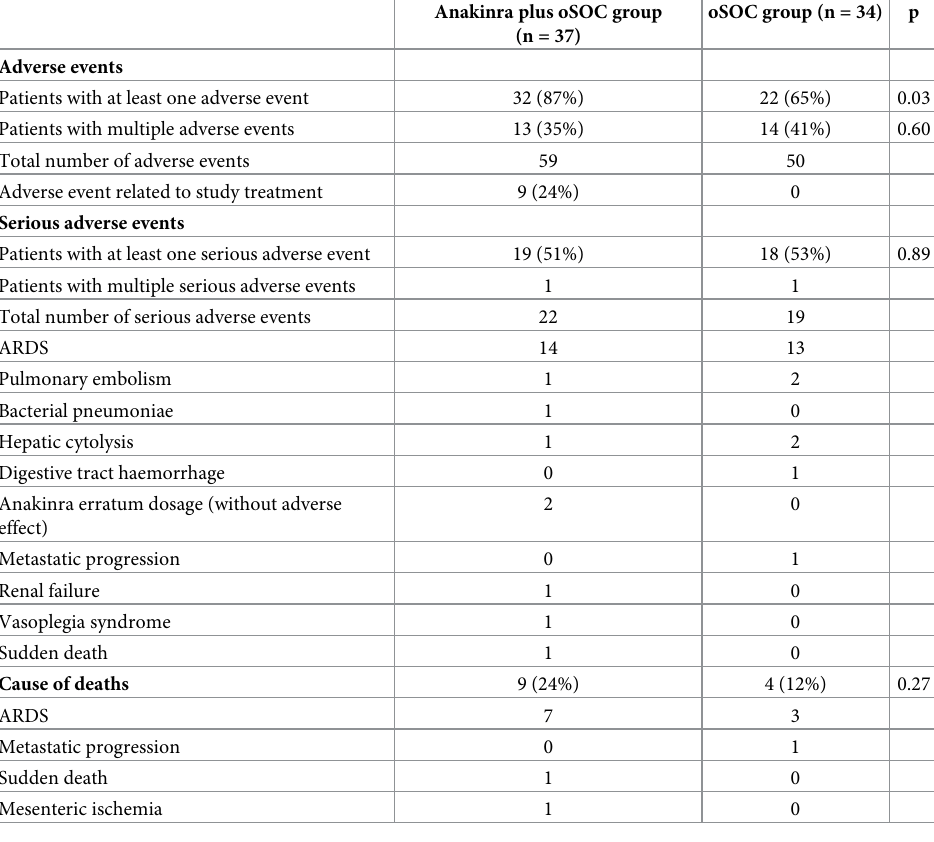
Table 5. Adverse events, serious adverse events and causes of